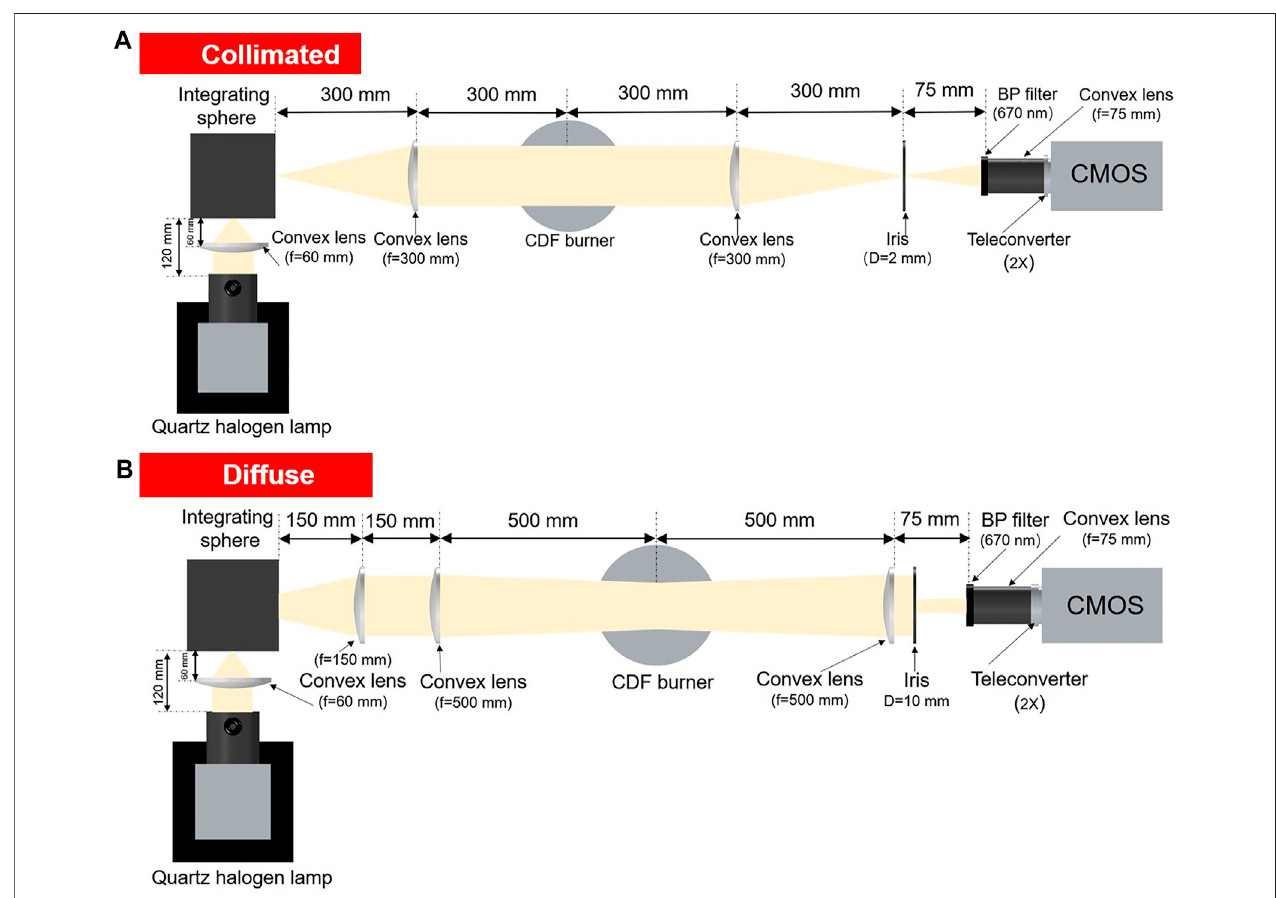
FIGURE 2 | Optical setup with the (A) collimated layout and (B) diffuse layout.